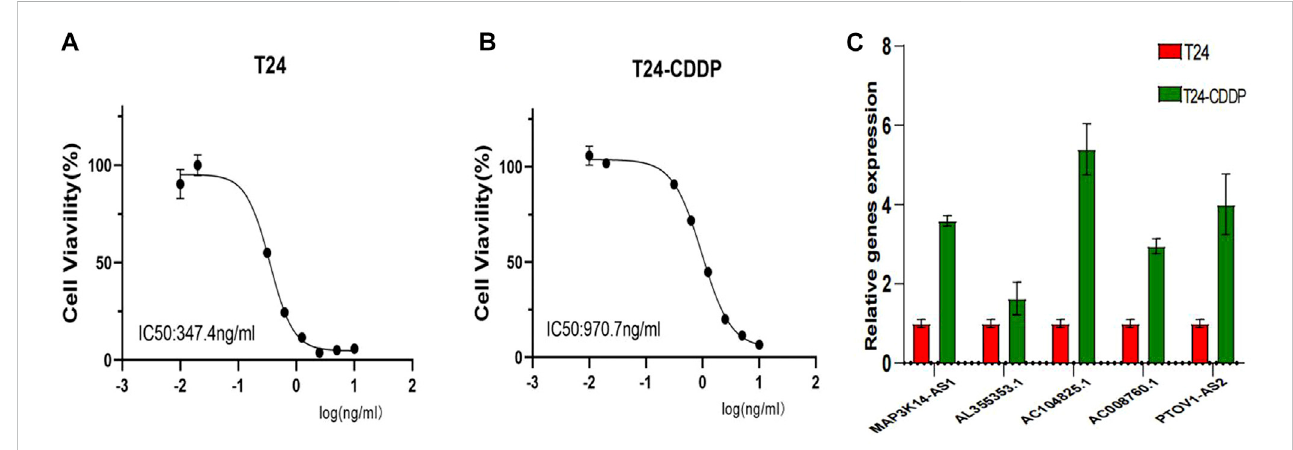
FIGURE 10 (A, B) Cisplatin IC50 for T24-CDDP and T24. (C) The expression of AC008760.1, PTOV1-AS2, AL355353.1, AC104825.1, and MAP3K14-AS1 in T24 and T24-CDDP cell